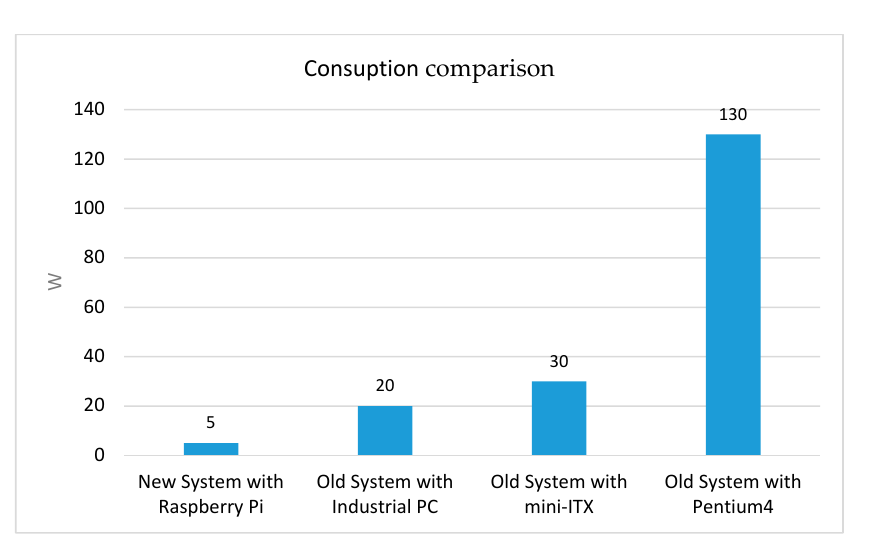
Figure 9. Power consumption comparison between the older probes and the new one.